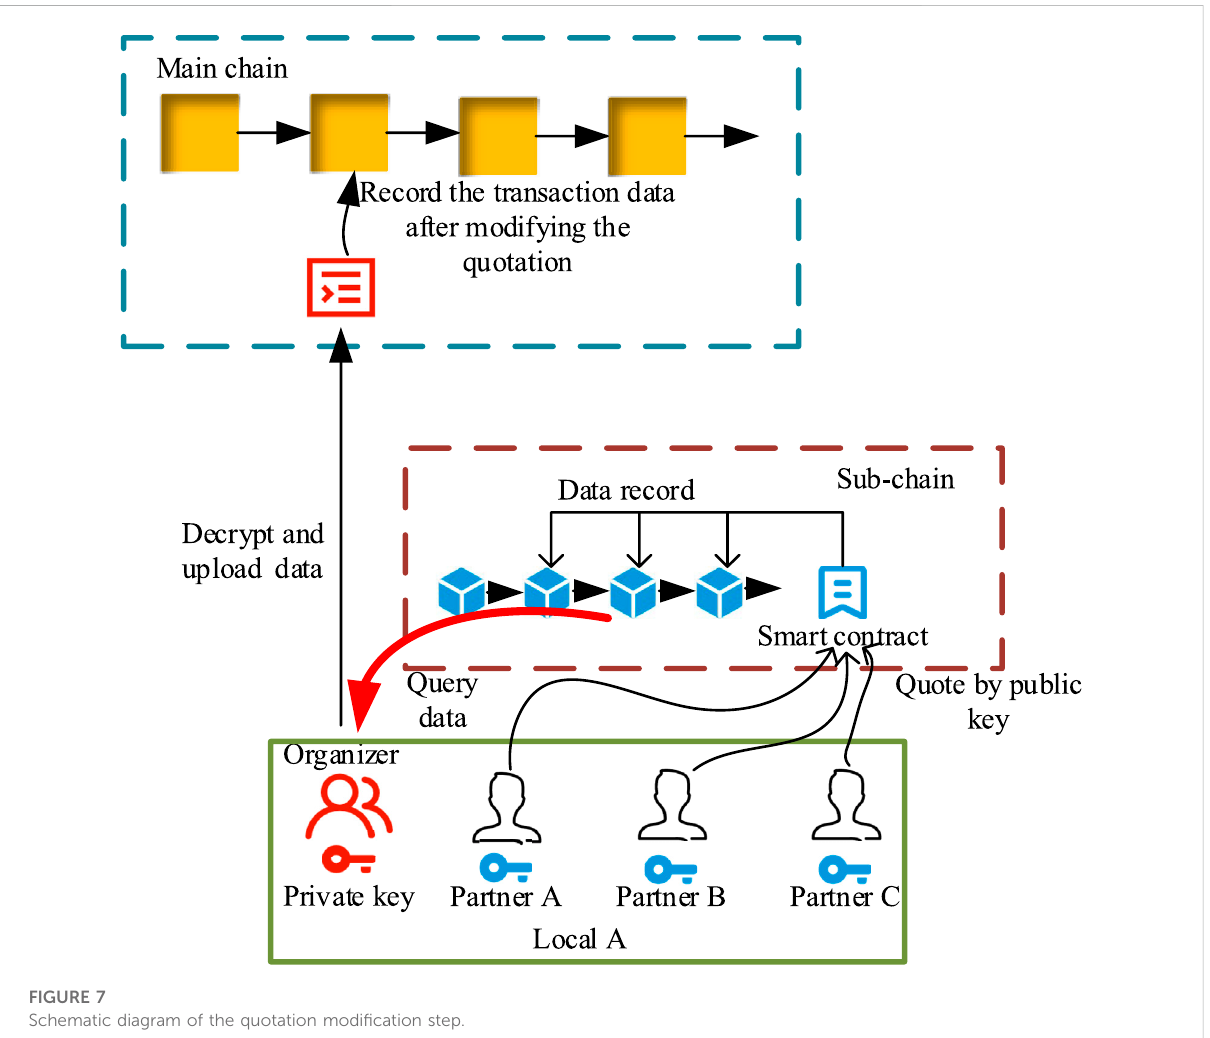
FIGURE 7 Schematic diagram of the quotation modi fi cation